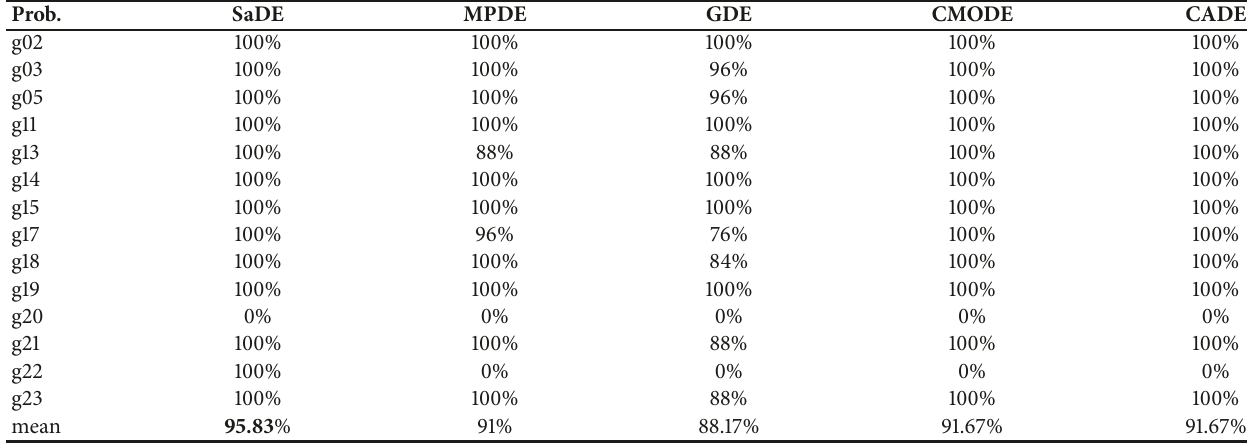
Table 6: Comparison of CADE with SADE, MPDE, GDE, and CMODE in terms of feasible rate. Prob.